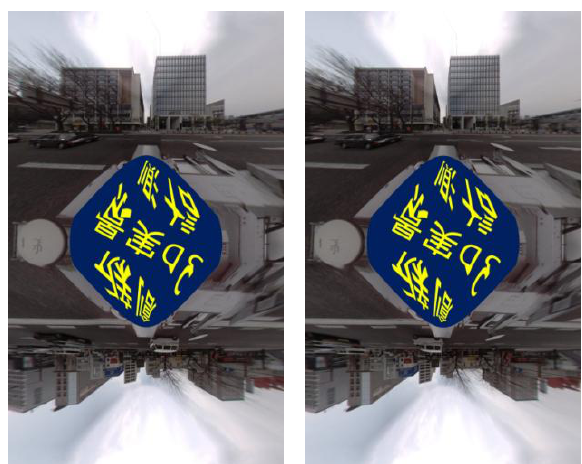
Figure 9. Both middle parts of the resampled stereo panoramic epipolar images with the standard perspective